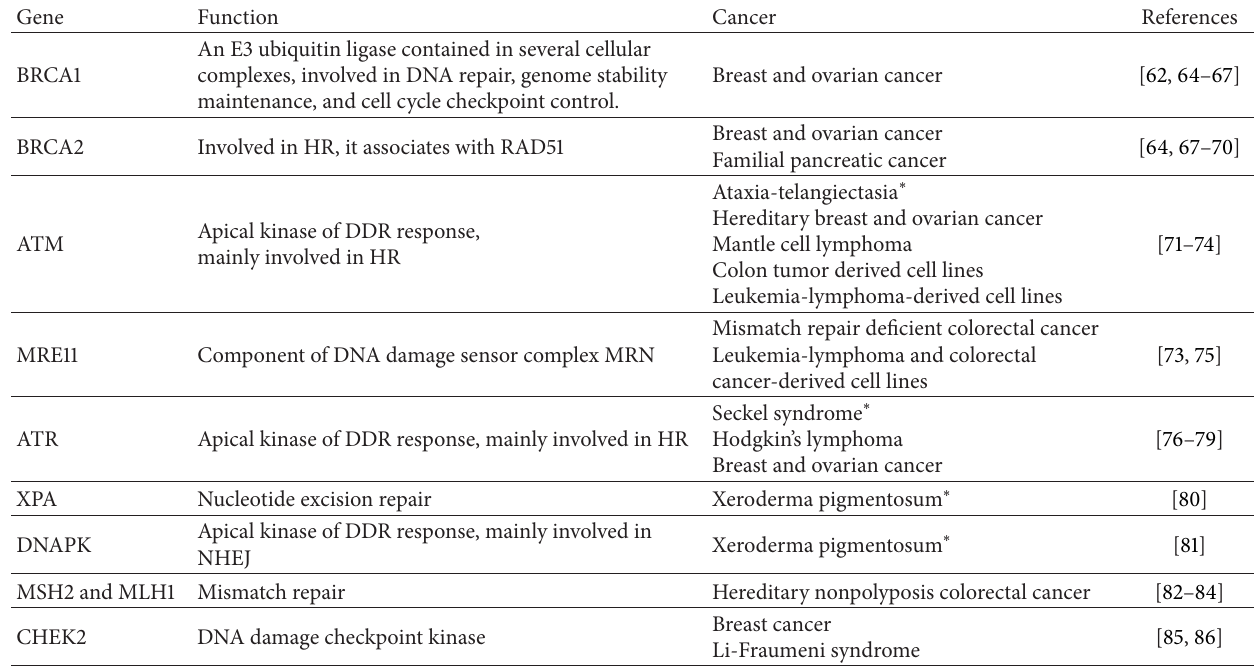
Table 1: List of DDR-related genes found to be aberrantly spliced in several cancer